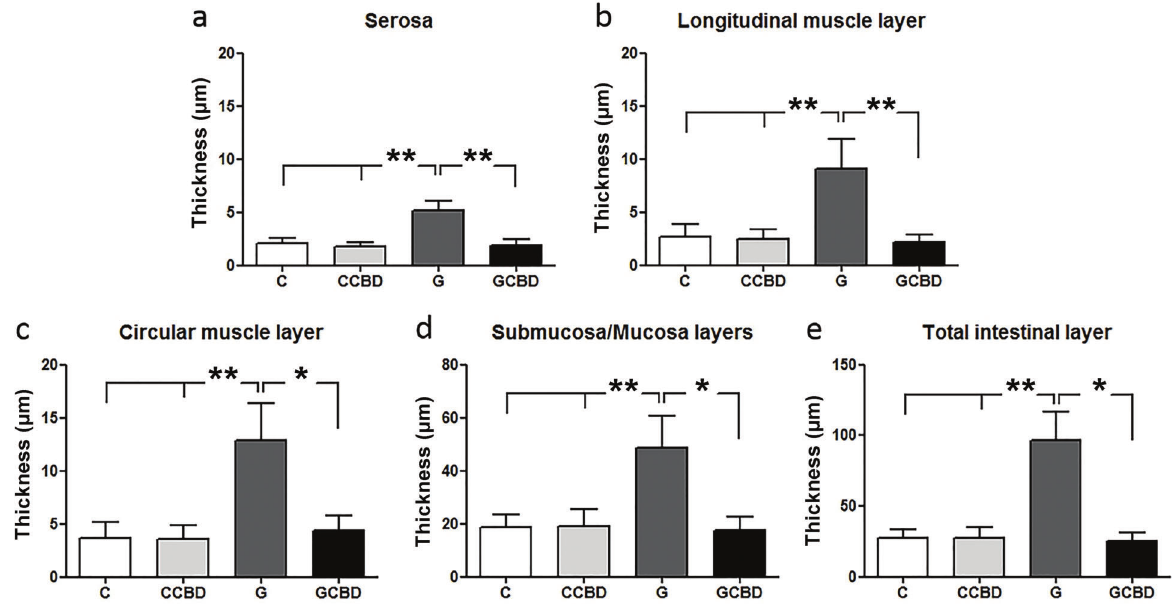
Figure 3. Histometric analysis of the intestinal layers. Data are reported as means ± SD. C: Control; CCBD: Control + cannabidiol; G: Gastroschisis; GCBD: Gastroschisis + cannabidiol. *P o 0.05; **P o 0.005